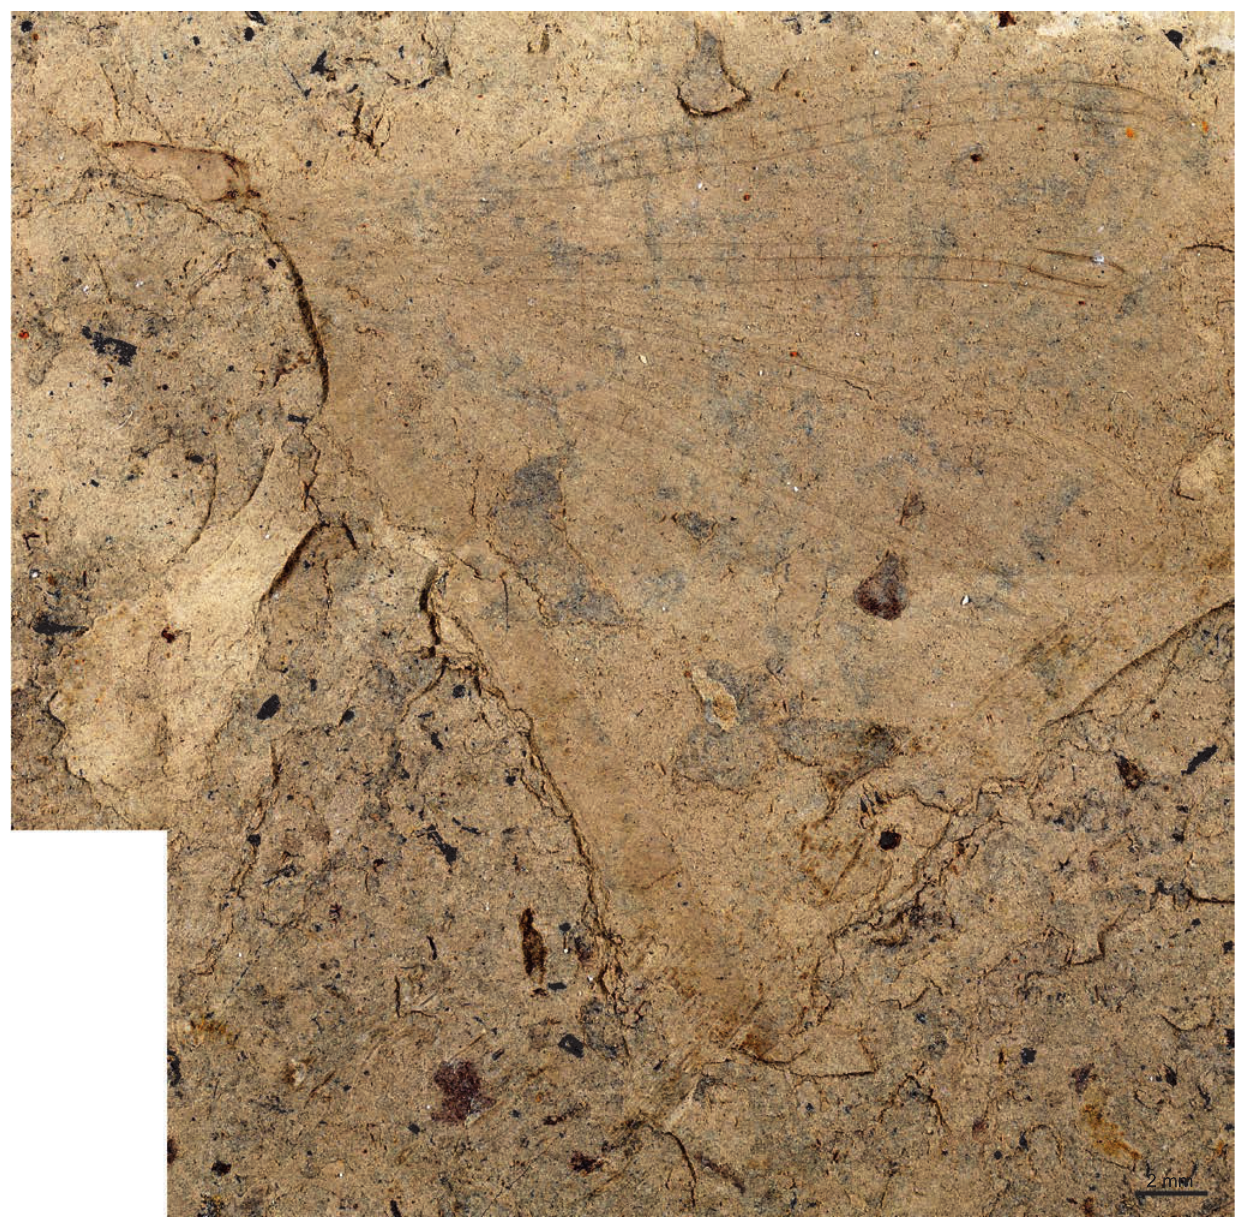
Fig. 7. Zygopteran odonatan Menatlestes palaeocenicus gen. et sp. nov., holotype MNT Nel Odo 2; from Paleocene, Menat, France. Habitus,